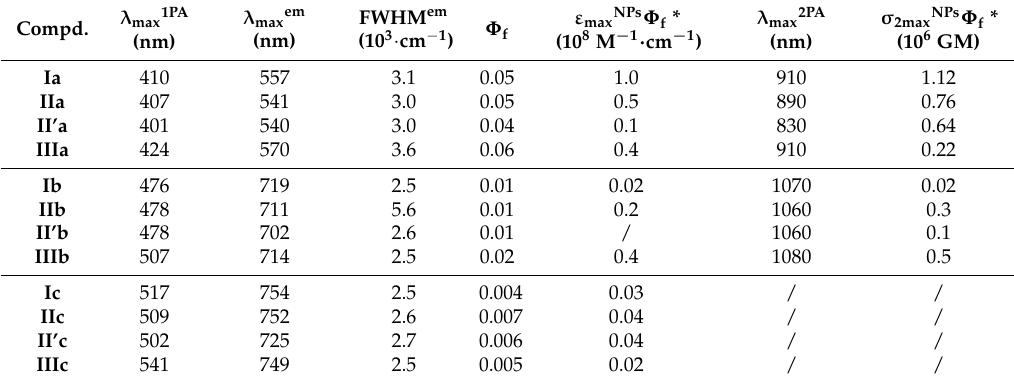
Table 5. Luminescence properties including one-photon and two-photon brightness of FONs.